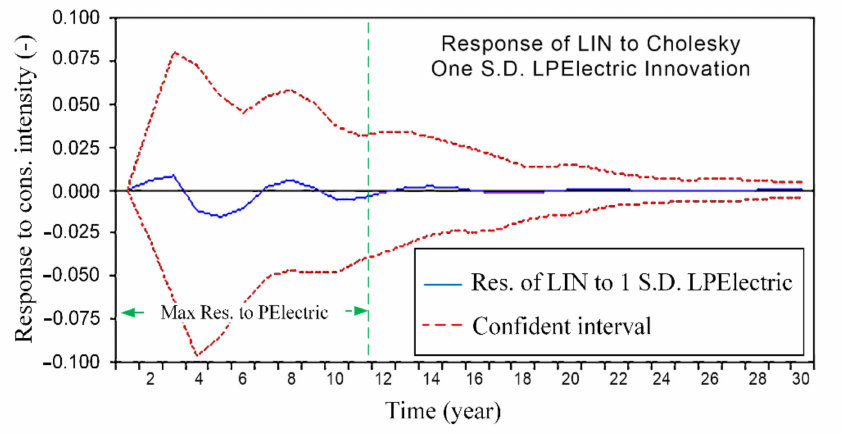
Figure 1. The estimated effect of an electricity price impulse on the rate of a standard deviation due to the energy consumption intensity, between